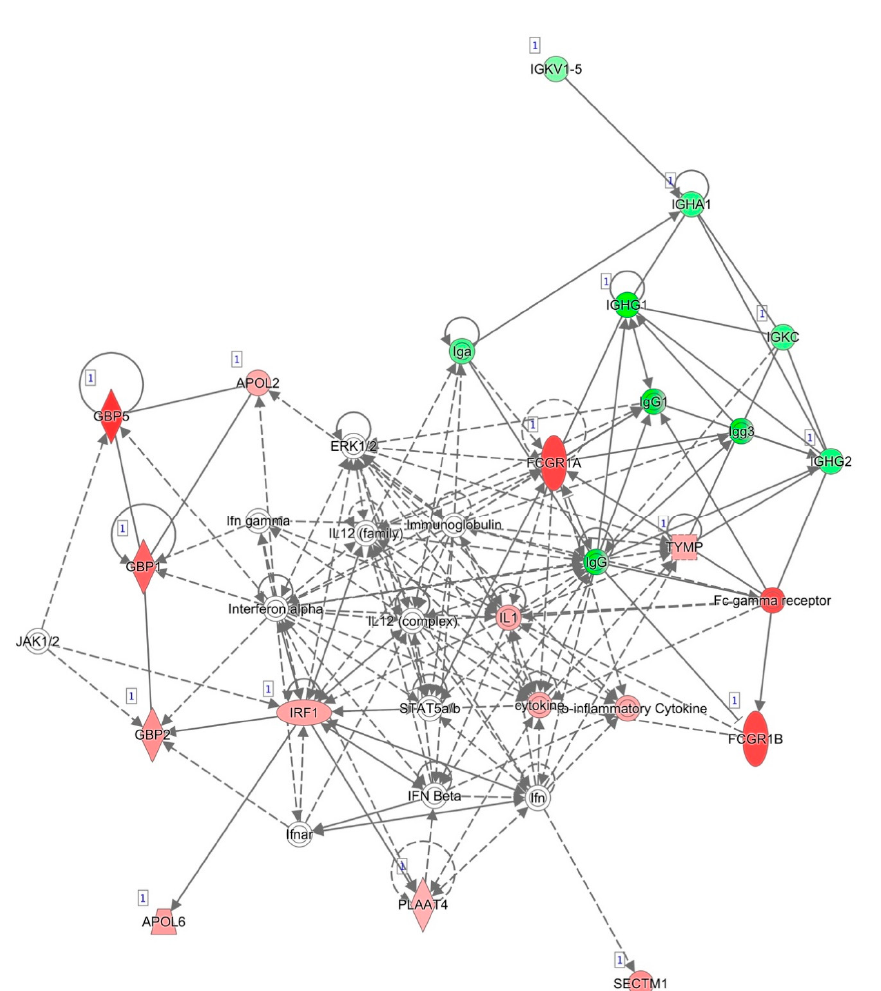
Figure 2. Network of differentially expressed genes after two weeks of anti-TNF treatment based on interactions using IPA. Red, genes overexpressed in non-responders vs. responders; green, genes downregulated in non-responders vs. responders.